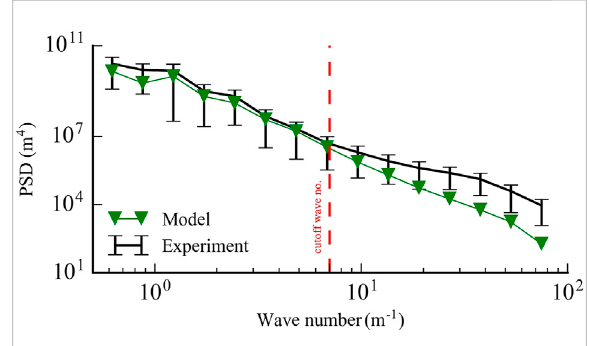
FIGURE 6 Powerspectraldensityofthemorphologyat t =8 h.Theerror bars of the experimental data are based on the standard deviation from the azimuthally averaged PSD in the wave number